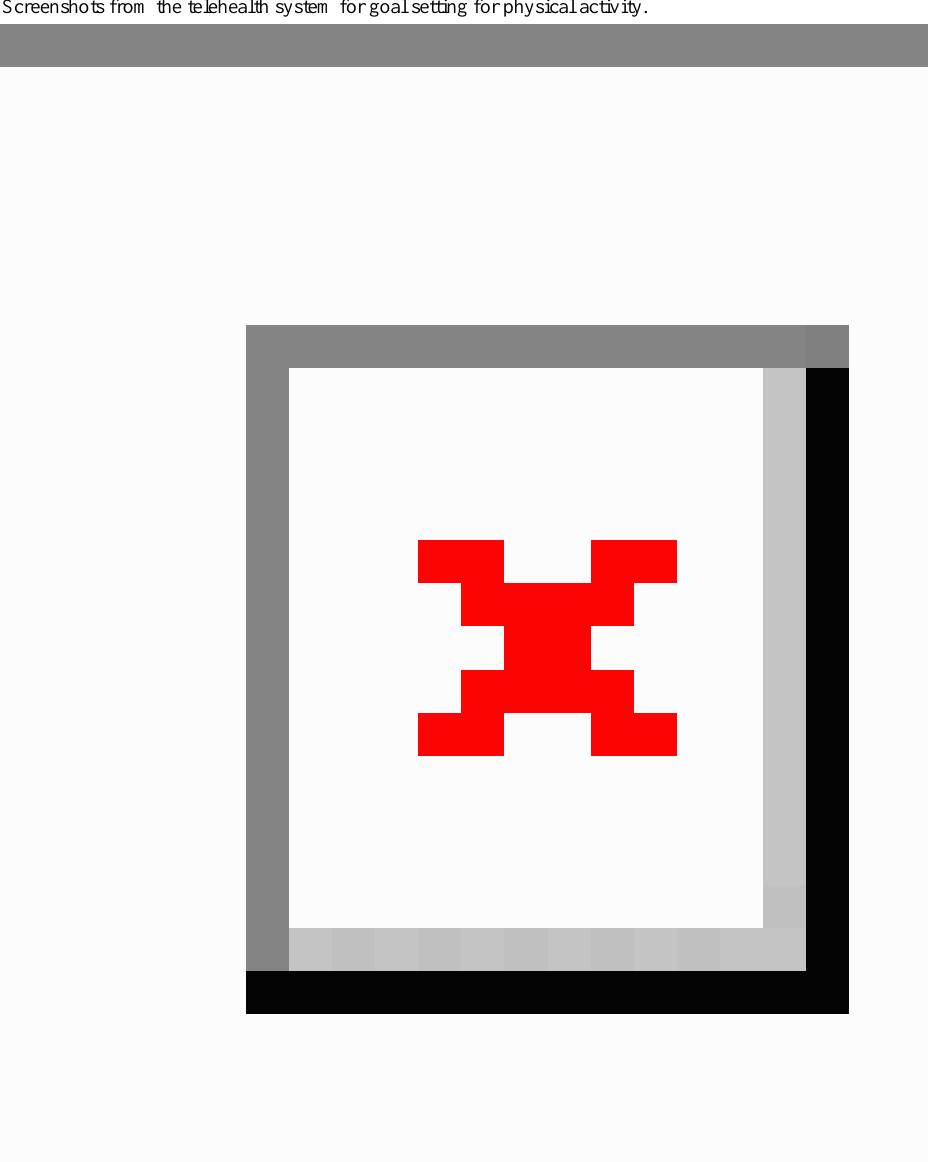
Figure 2. Screenshots from the telehealth system for goal setting for physical